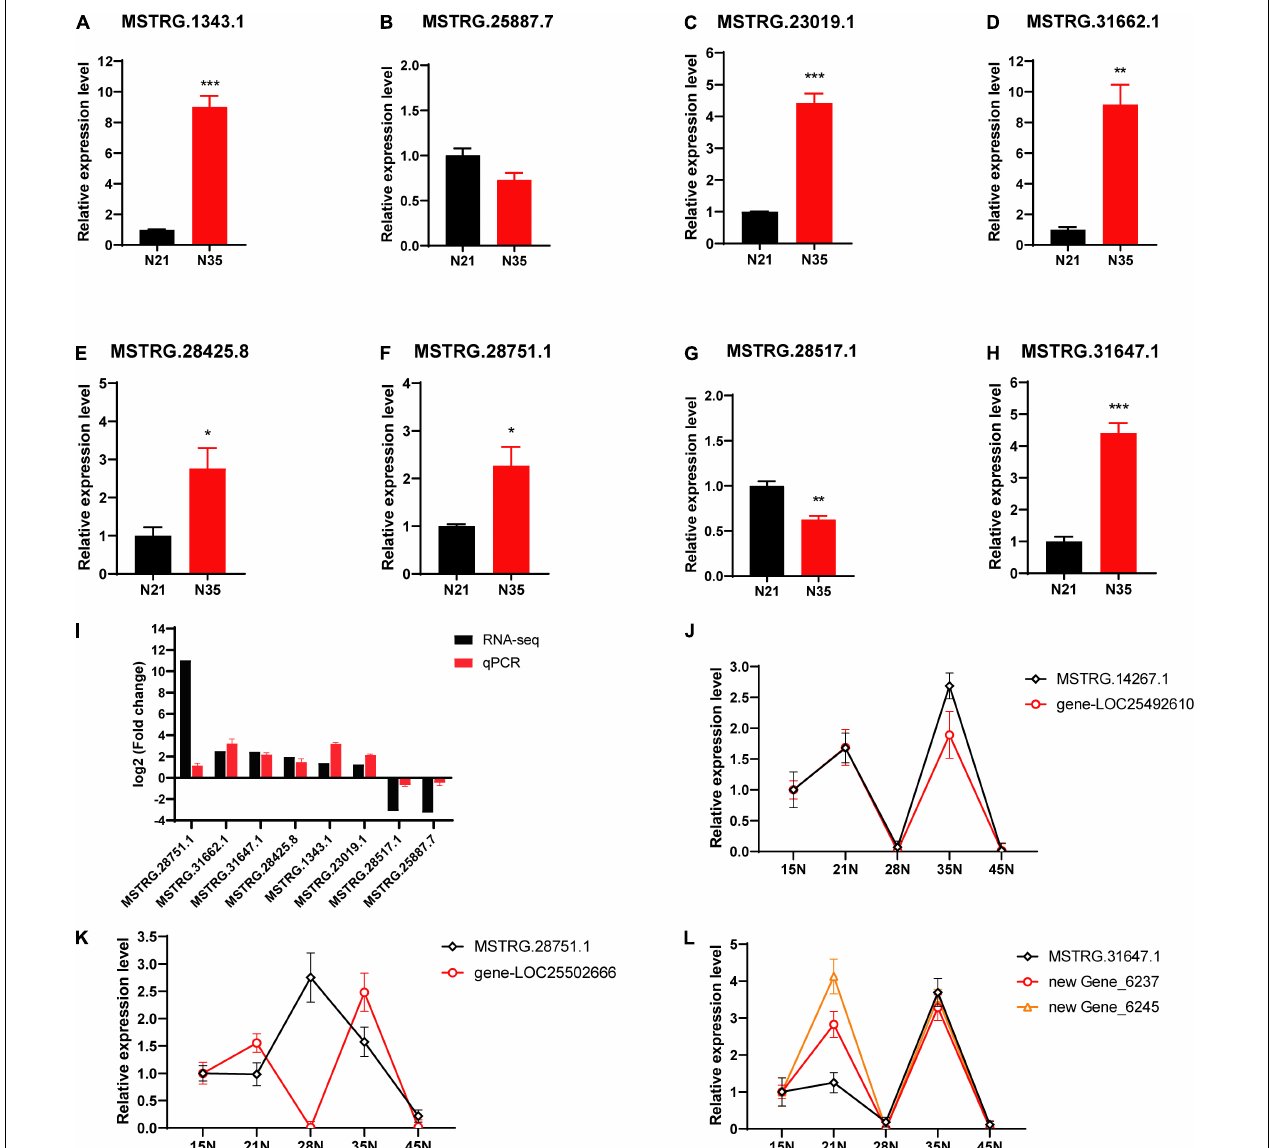
FIGURE 6 | Expression validation of lncRNAs and their targets by qRT-PCR. (A–H) Validation of lncRNAs. *, ** and ***, respectively, represent difference significant at p < 0.05, p < 0.01 and p < 0.001. Error bars represent standard errors. (I) Comparison with the log2 (Fold change) for selected lncRNAs calculated by